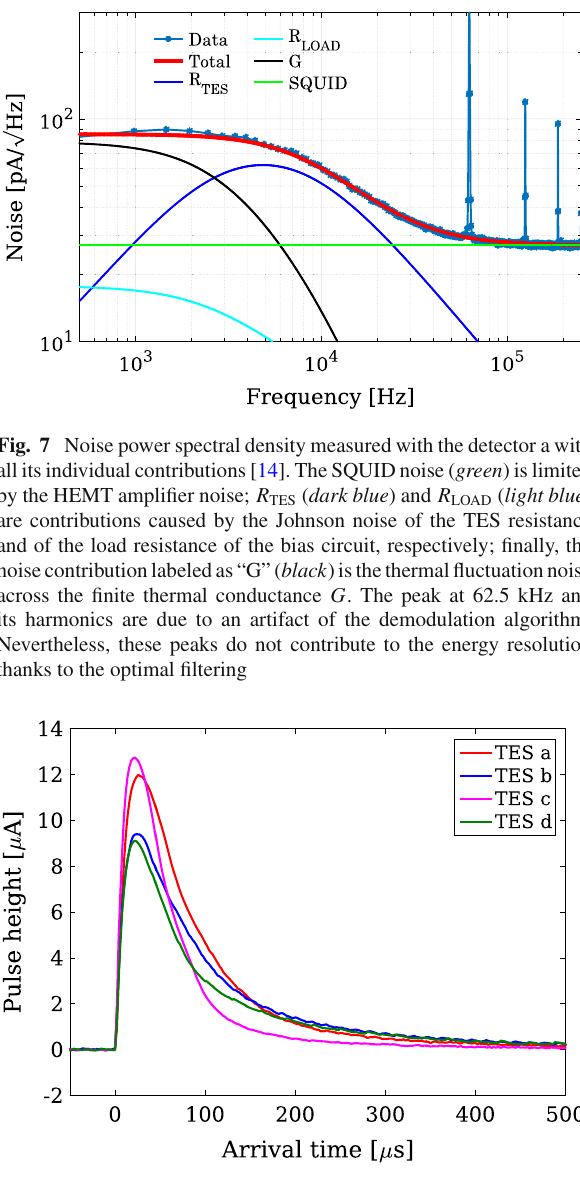
Fig. 8 Example of single event pulses due to the chlorine X-rays ( ≈ 2.6 keV) for the four different detector under study. The difference in amplitude among the four designs is explained in Fig. 6